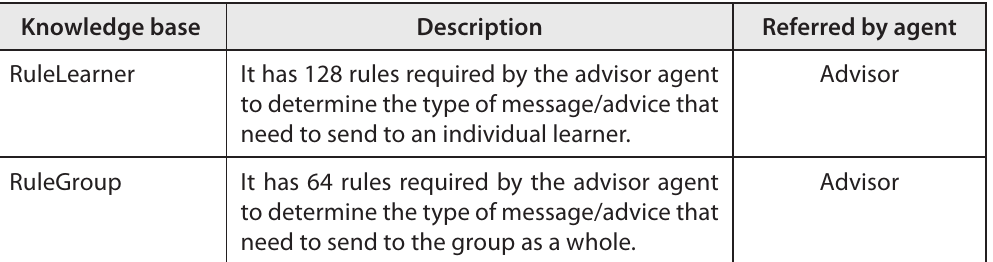
Learner and group